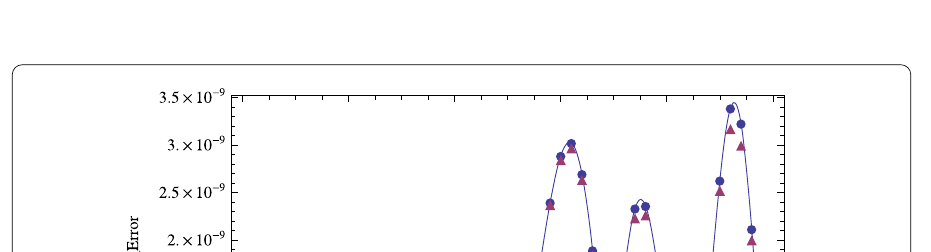
all three derivatives, and they are indistinguishable on graphics. In addition, illustrations show the availability and usefulness of the OPIAs for the system of differential